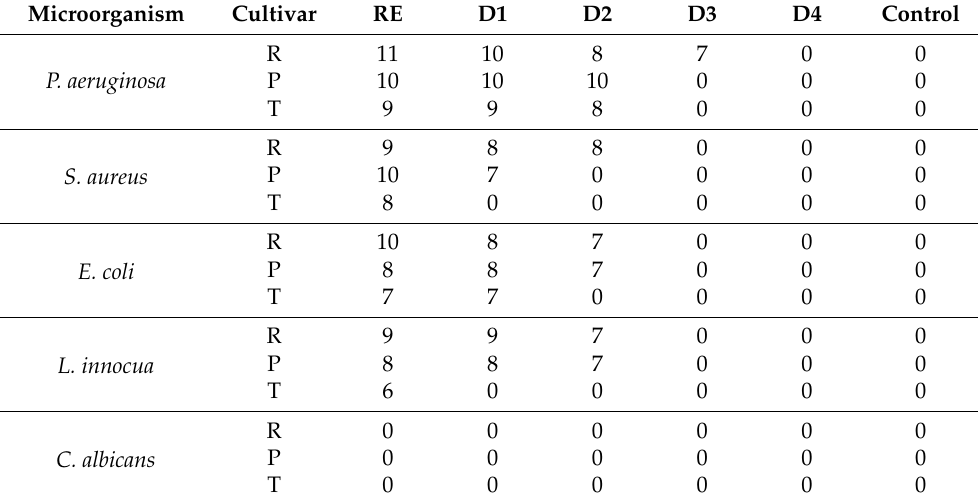
Table 4. Results of antimicrobial activity assays of the extracts of the Romana (R), Pizzuta (P), Tuono (T) almond